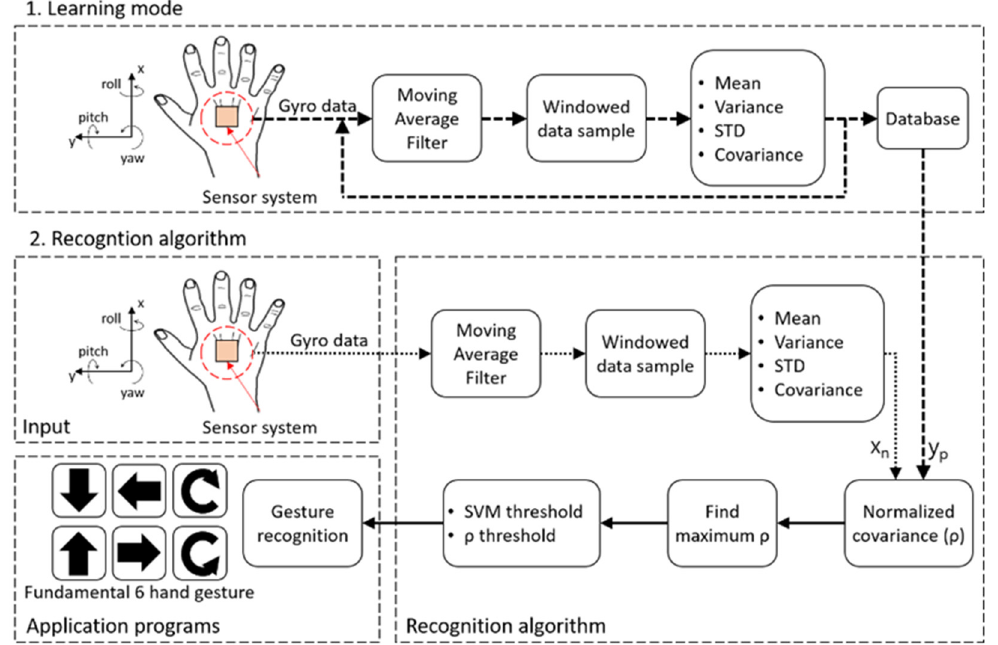
Figure 1. Flowchart of the system data.